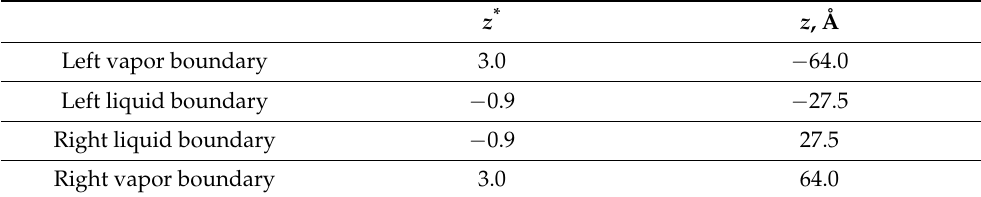
Table 2. The normalized and absolute simulation boundary positions listed in Figure 1. z * z , Å Left vapor boundary 3.0 − 64.0 Left liquid boundary − 0.9 − 27.5 Right liquid boundary − 0.9 27.5 Right vapor boundary 3.0